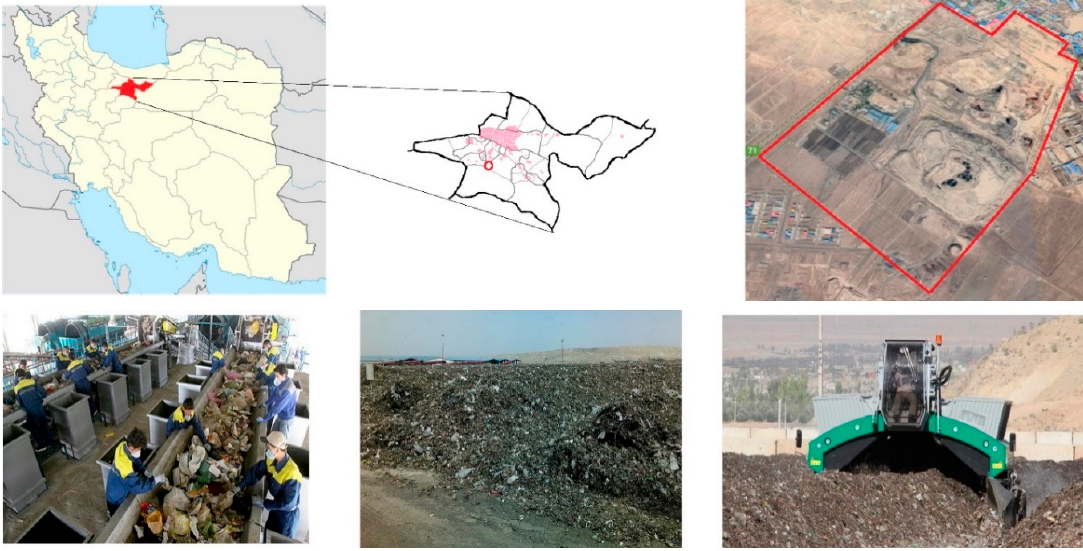
Figure 2. Location of compost site in Aradkouh processing and disposal complex.